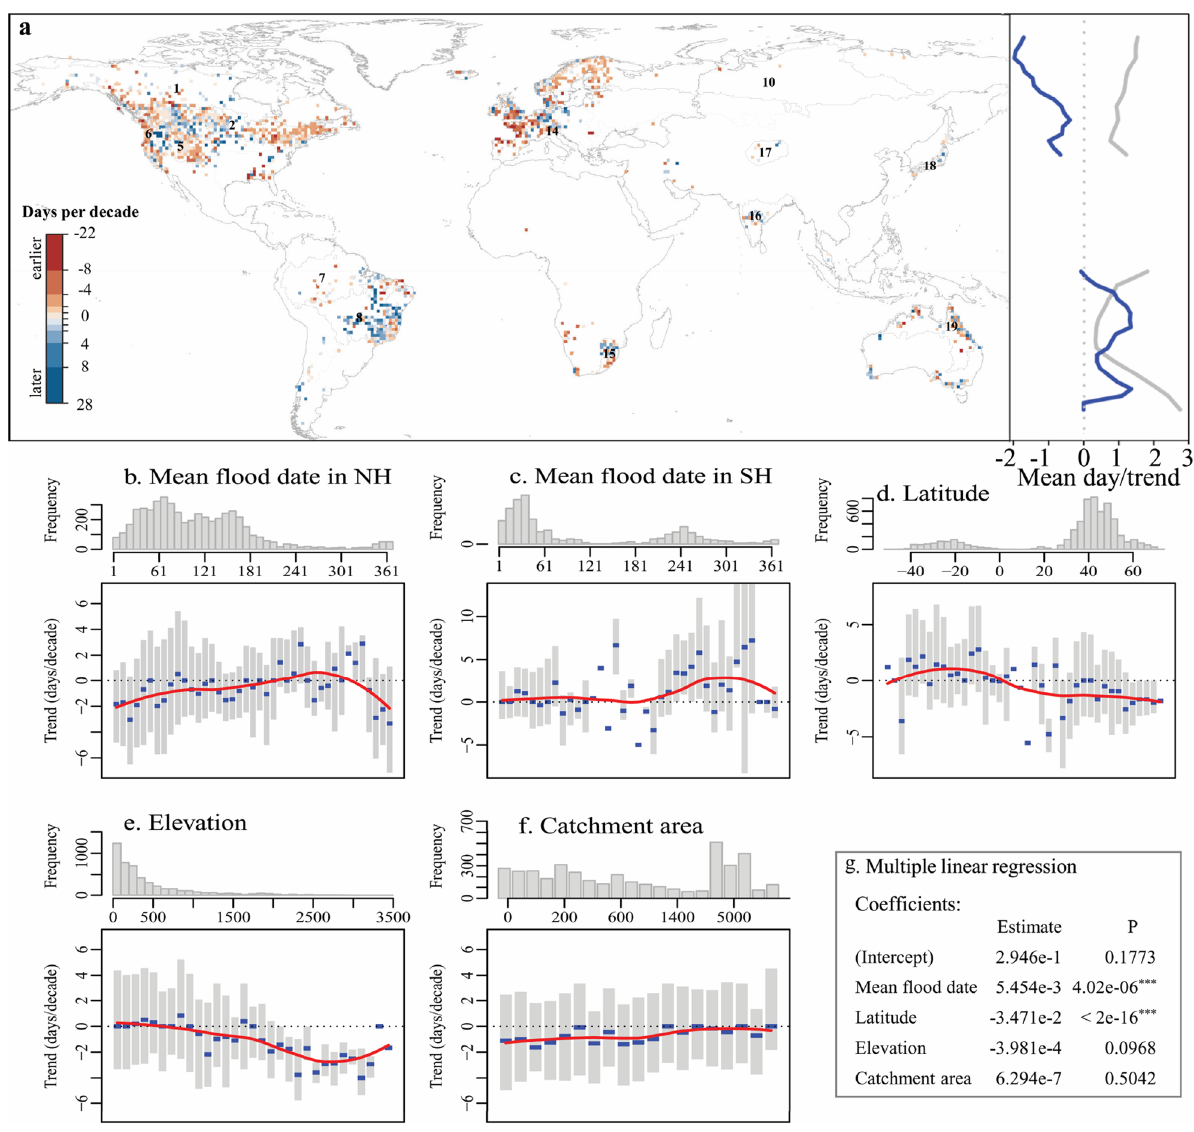
Figure 2. Global distribution of the trend in observed flood timing during 1970–2010 with latitude average flooding date (gray line; for display purposes the magnitude of the flood date is scaled by a factor of 0.01) and trend in flood timing (blue line) ( a ). Boxplots b-f demonstrate the relations between the trend in flood timing and mean flood date in the northern hemisphere (NH) ( b ) and southern hemisphere (SH) ( c ), latitude ( d ), outlet elevation ( e ) and catchment area ( f ). The interquartile range, equaling the difference between the 25th and 75th percentiles, is used to characterize variability for each bin. The red lines represent a loess-curve fitted to the values. The station density was also displayed in subplot ( b – f ). Subplot ( g ) shows the multiple linear regression analysis between flood timing trend with flood mean date, latitude, elevation and